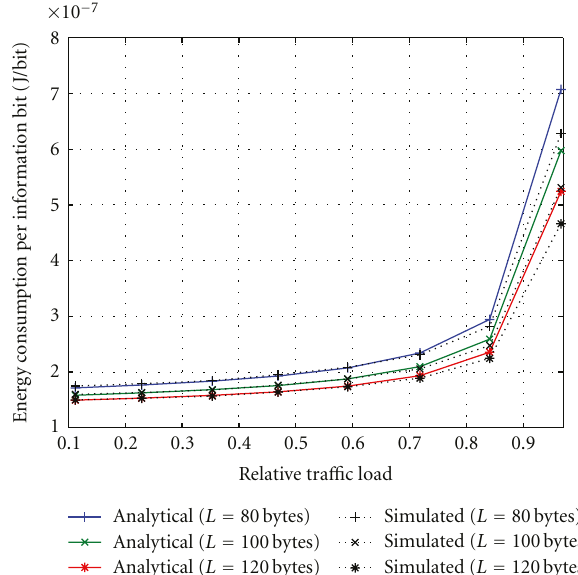
Figure 8: DQ-MAC energy consumption per information bit: Analytical versus Simulation.